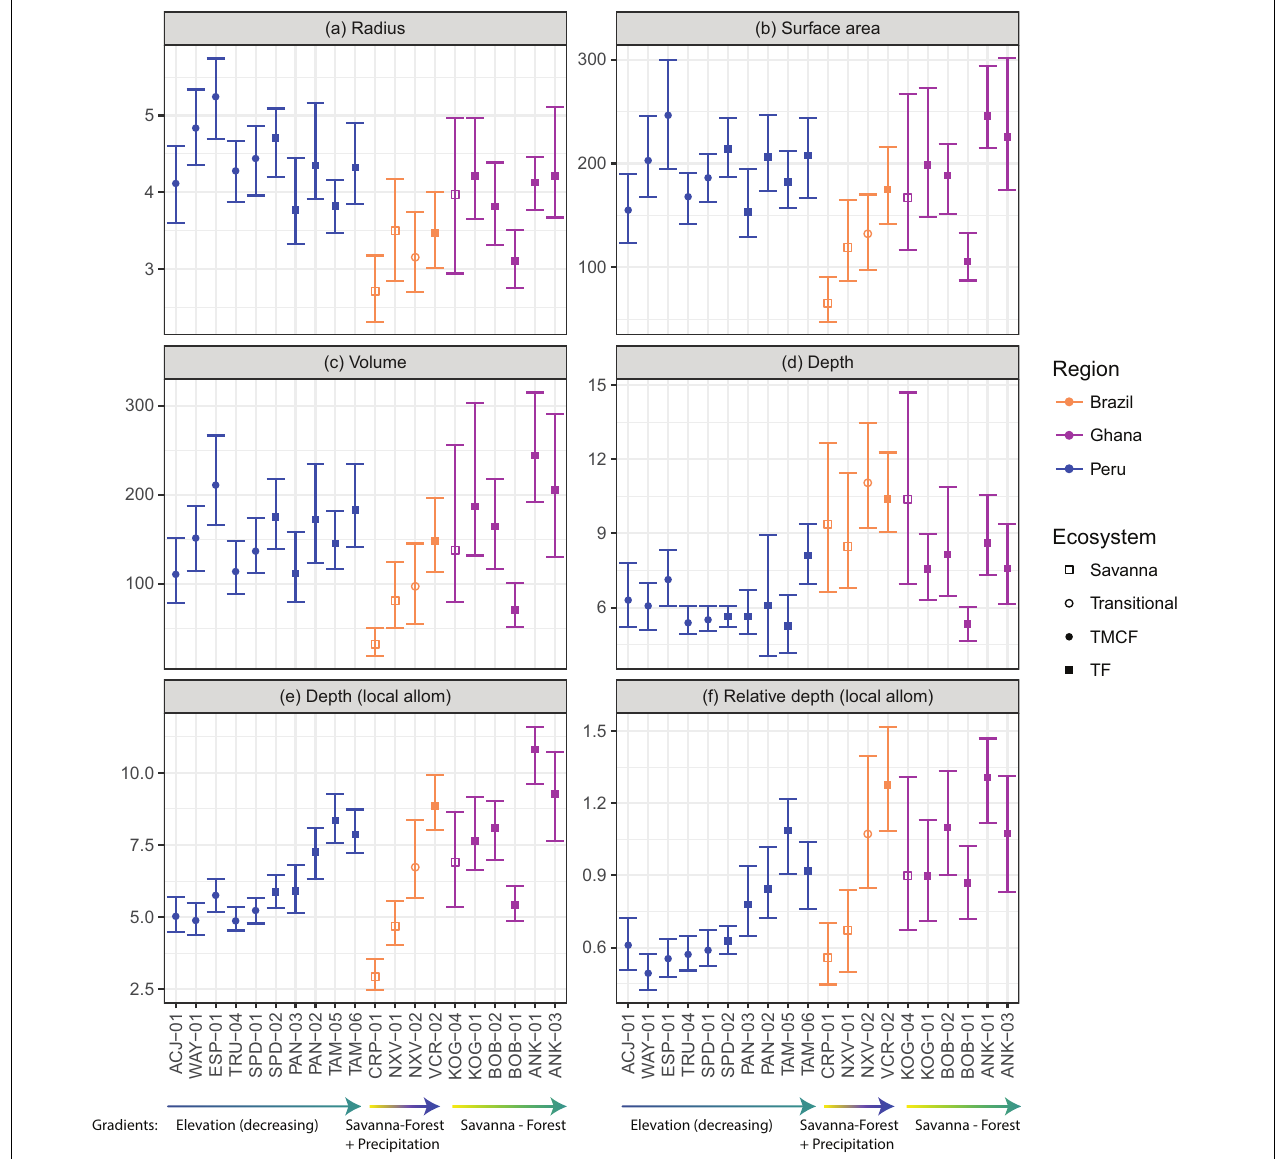
FIGURE 6 | Modeled crown dimensions and 95% CIs for a 30 cm DBH tree. The crown depth model also included tree height, which was fixed in (d) using our height vs stem radius allometry (see Supplementary Material ) and averaged across sites so the same DBH and height were used for each site. Tree height of a 30cm DBH tree was allowed to vary across sites in (e,f) based on the mean per-site height – DBH allometry (Model 2). Predictions are derived from the following LMM models described above: (a) Model 7, (b) Model 8, (c) Model 9, (d) Model 12, (e) Model 12, (f) Model 15. CIs were estimated using a bootstrap algorithm with 100 iterations. Units are m, m 2 , and m 3 . See Supplementary Figure S31 for predictions for other tree